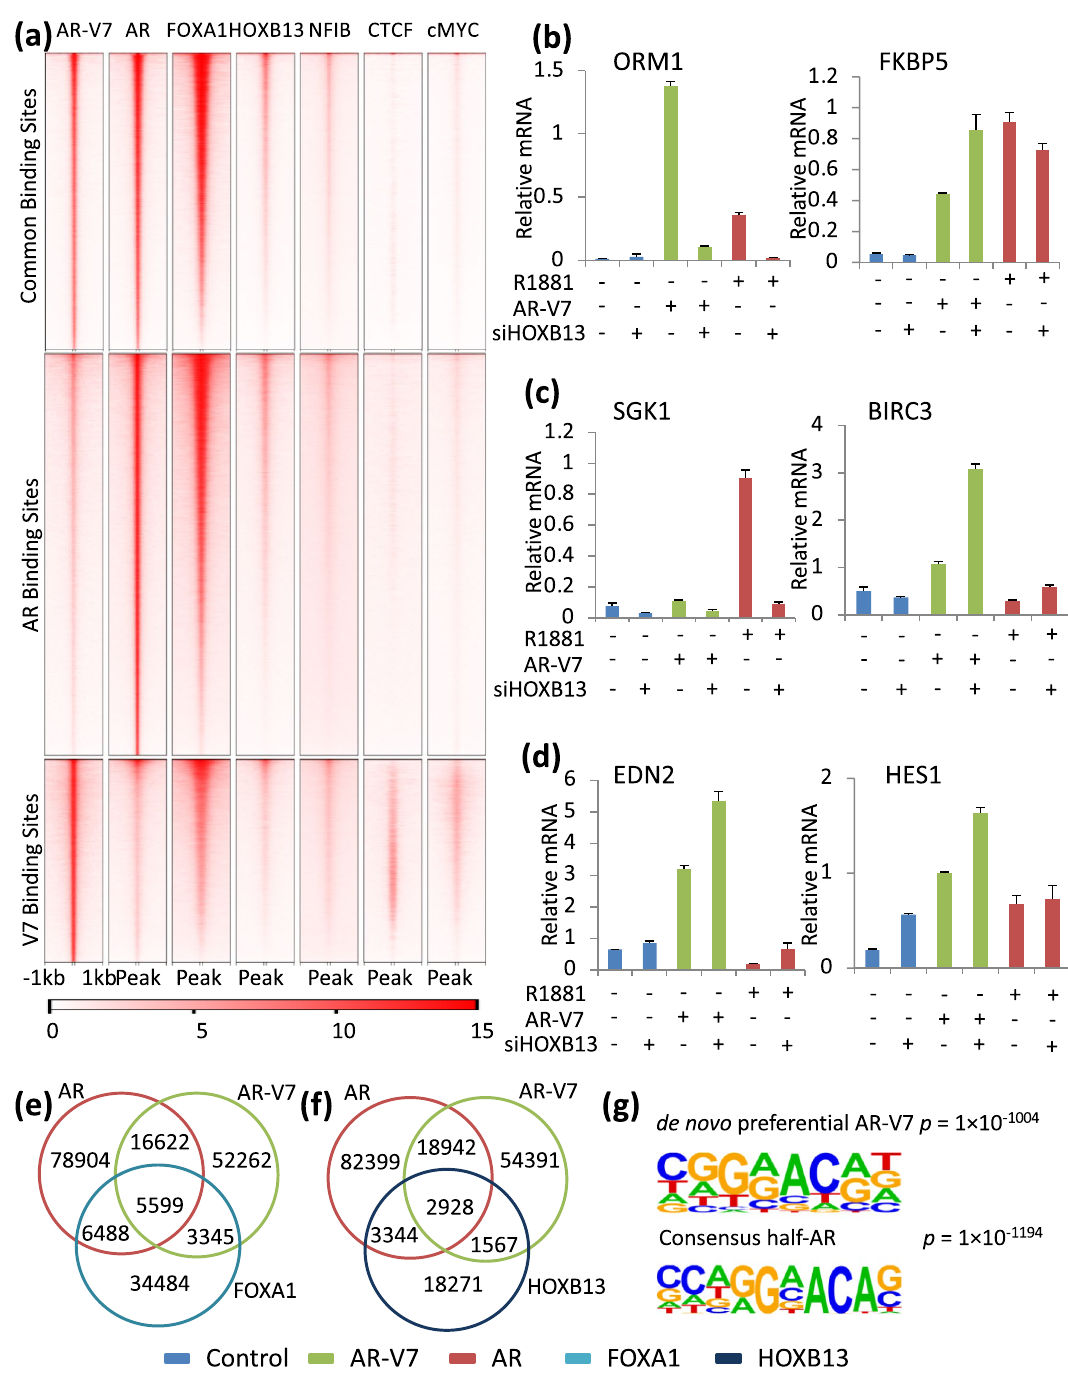
Figure 7. Role of other factors in differential gene regulation. ( a ) AR, AR-V7, FOXA1, HOXB13, NFIB, CTCF, cMYC average ChIP-seq signal intensity per every 10 bp bin at common, AR and AR-V7 binding sites identified in Fig. 3, panel a. Data were generated from LNCaP cells and ChIP signals plotted are within ± 1 kb from the center of AR and AR-V7 binding sites using publicly available data listed in STable 1. ( b–d ) qPCR analysis measuring gene expression upon HOXB13 depletion using the method previously described for FOXA1. All qPCR plots are expression values normalized to 18S on the y -axis and corresponding treatment on the x -axis. Data are plotted as mean of three biological replicates from the same experiment and error bars are SEM. Each experiment was performed a minimum of three times and a representative experiment is shown here. ( e ) Venn diagram showing number of AR and AR-V7 binding sites in LNCaP AR-V7 cells overlapping FOXA1 binding sites in LNCaP cells (peaks with a local FC > 5 and at least a base pair overlap). ( f ) Venn diagram showing number of AR and AR-V7 binding sites in LNCaP AR-V7 cells overlapping HOXB13 binding sites in LNCaP cells (peaks with a local FC > 5 and at least a base pair overlap). ( g ) Consensus sequence reported by HOMER motif analysis of all AR-V7 peaks identified from LNCaP AR-V7. Motif enrichment p value for de novo motif and known half ARE motif were calculated using cumulative binomial distribution. Venn diagrams ( e , f ) are plotted as symmetrical circles and not proportional to